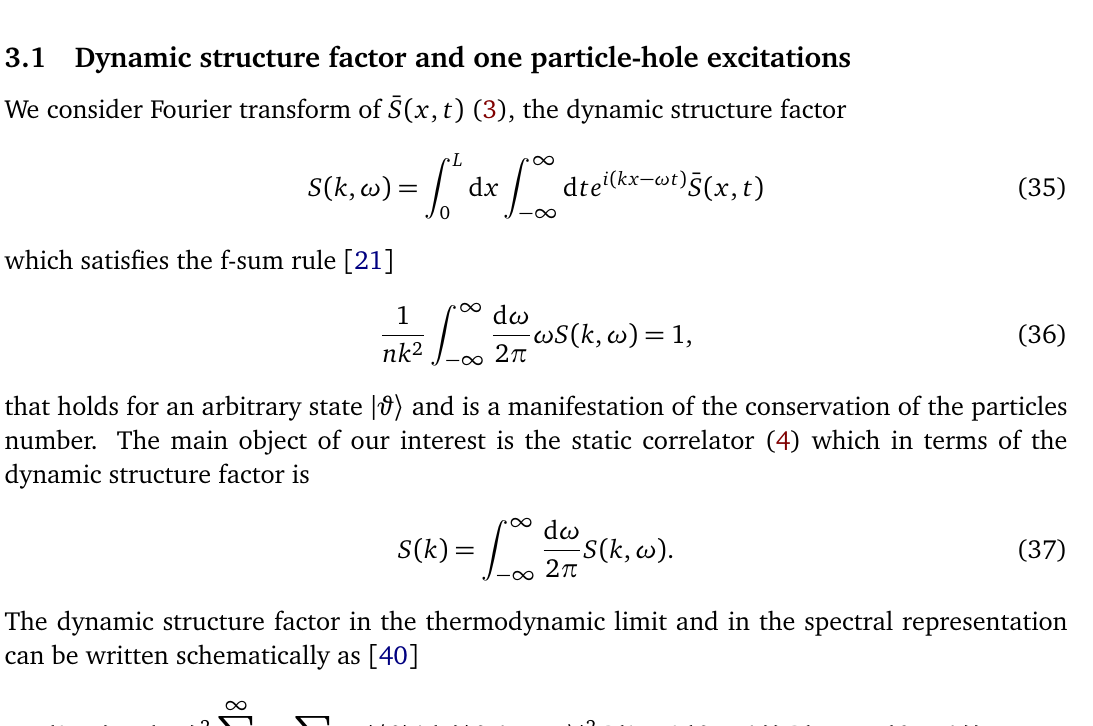
( k , ω ) at fixed k obtained from a numerical evaluation of the m = 1 Figure 2: Plot of S T contribution (one particle-hole excitations) of equation (38) with k = k / 5 (right) ( k = π n ) for a thermal gas with T = 1, n = 1 and for two different values of the k F F coupling c = 1 (red line) and c = 2 (blue